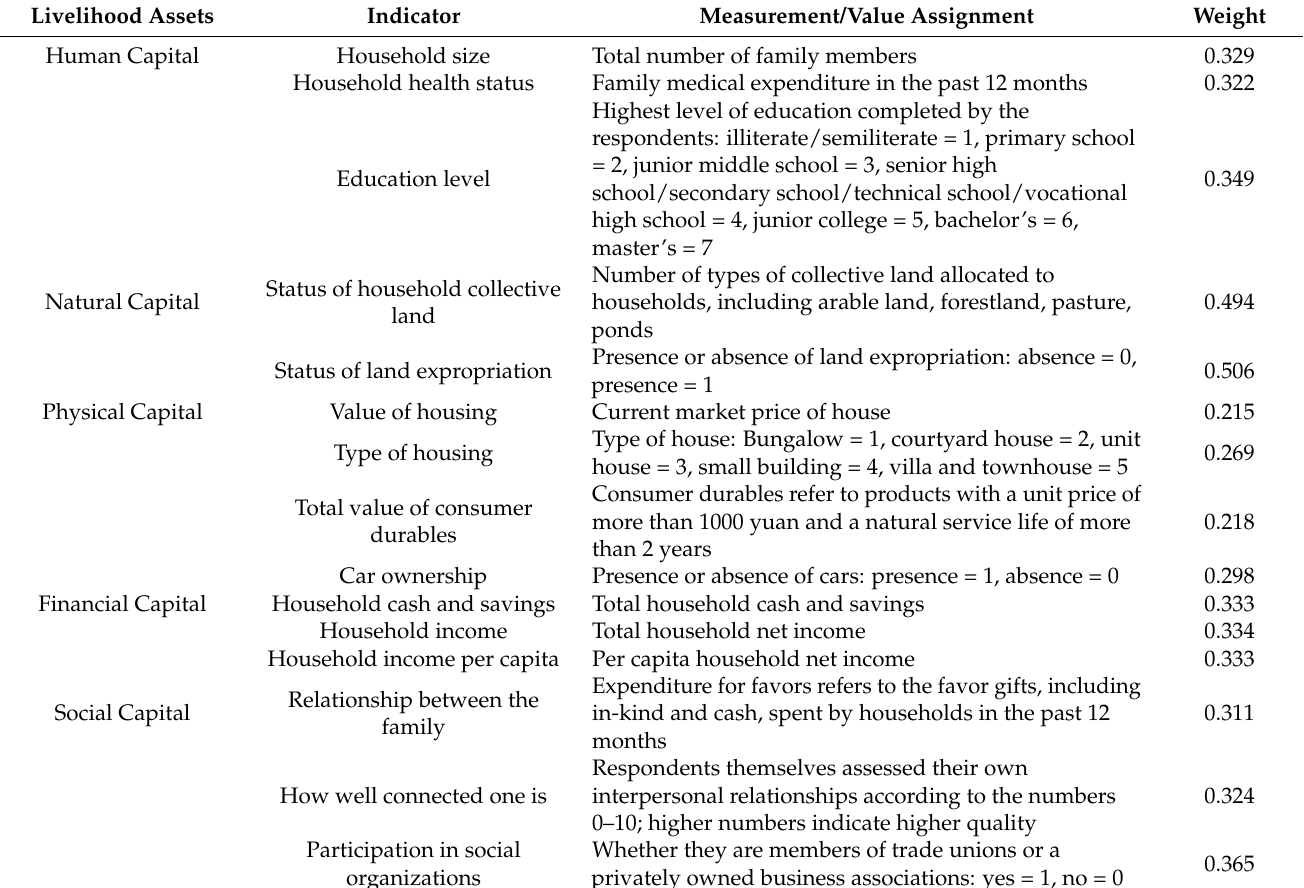
Table 2. Livelihood asset evaluation